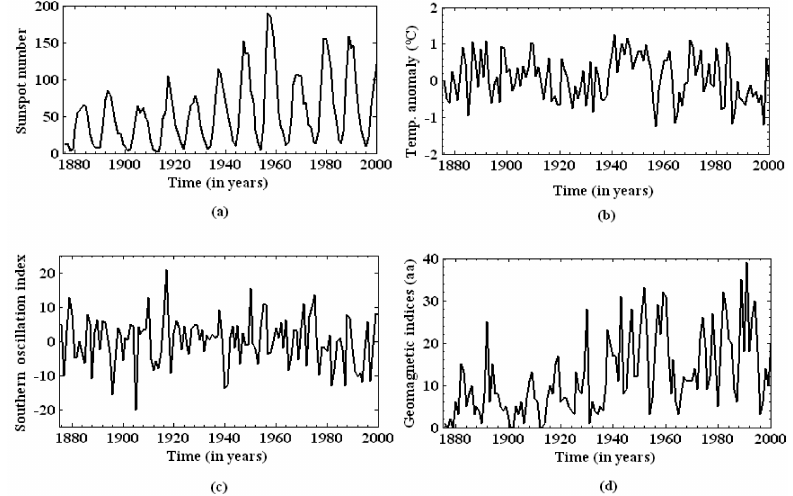
Figure 1. Time series data of (a) sunspot index, (b) the mean pre-monsoon temperature anomalies of the Western Himalayas (Yadav et al., 2004), (c) the Southern Oscillation Index (SOI) and (d) geomagnetic indices (aa indices) for the common period